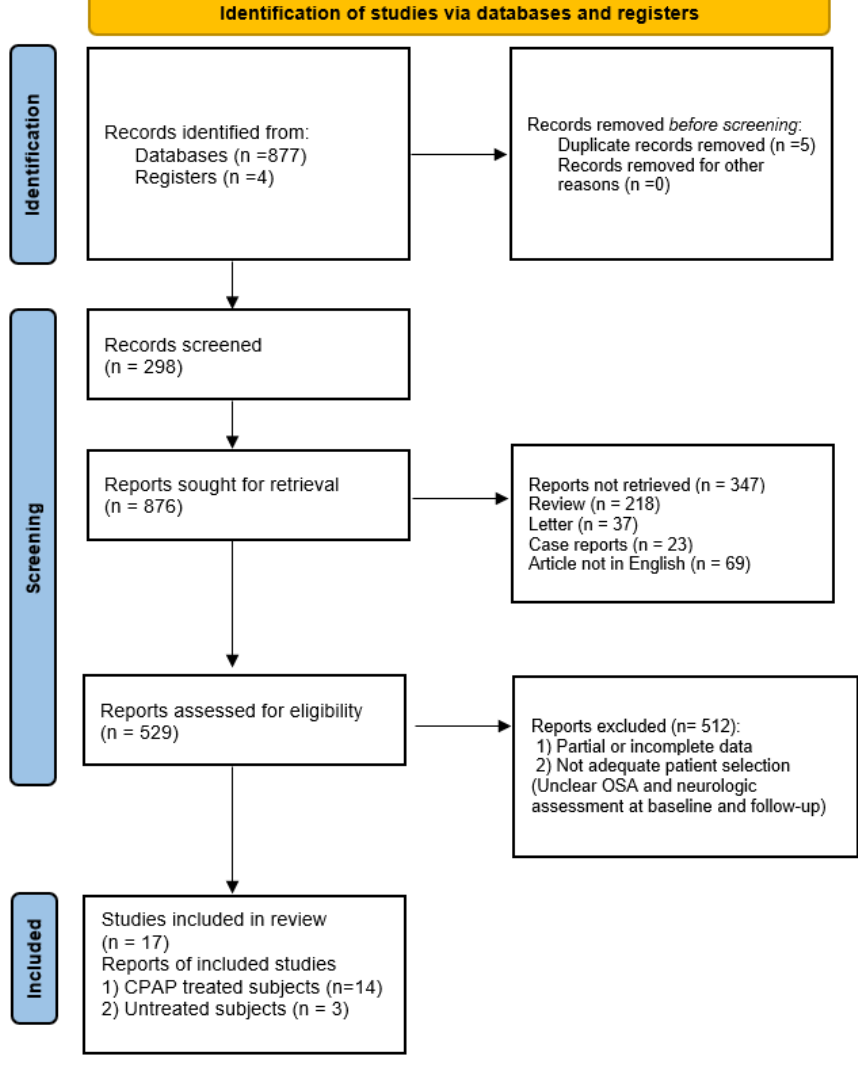
Figure 2. PRISMA flow diagram.